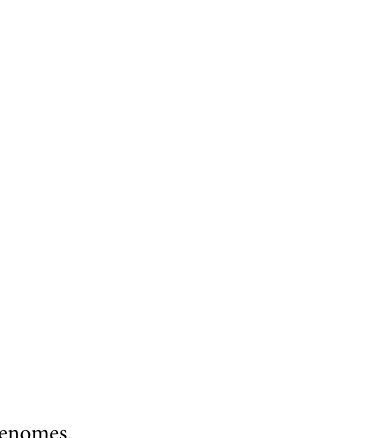
Table 3. Comparison of general features of Euphorbiaceae plastid